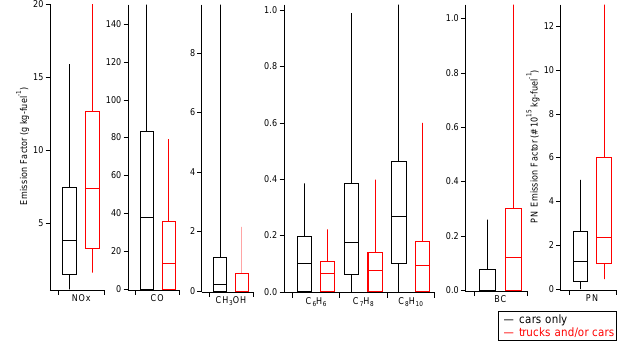
Figure 5. Box and whisker plot of the emission factors for indi- vidual plume analysis separated between periods with no influence from trucks (red) and periods with at least one passing truck (black). Horizontal lines represent the median values, boxes represent the 75th percentile and whiskers represent the 90th